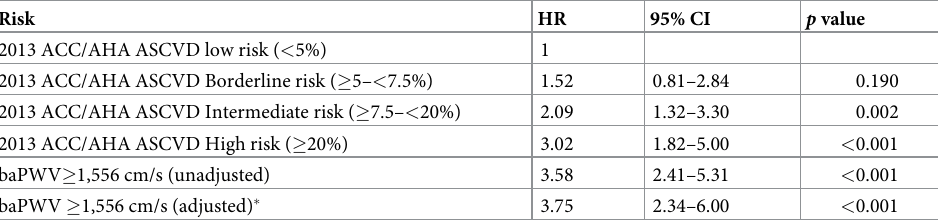
Table 3. Prognostic values of 2013ACC/AHA risk score and baPWV in predicting cardiovascular events. Risk HR 95% CI p value 2013 ACC/AHA ASCVD low risk ( < 5%) 1 2013 ACC/AHA ASCVD Borderline risk ( � 5– < 7.5%) 1.52 0.81–2.84 0.190 2013 ACC/AHA ASCVD Intermediate risk ( � 7.5– < 20%) 2.09 1.32–3.30 0.002 2013 ACC/AHA ASCVD High risk ( � 20%) 3.02 1.82–5.00 < 0.001 baPWV � 1,556 cm/s (unadjusted) 3.58 2.41–5.31 < 0.001 baPWV � 1,556 cm/s (adjusted) � 3.75 2.34–6.00 2013 ACC/AHA ASVD risk score: 2013 American College of Cardiology/American Heart Association atherosclerotic cardiovascular disease risk score, baPWV: brachial-ankle pulse wave velocity, HR: hazard ratio, CI: confidence interval. � Covariates were controlled as potential confounders: Age, Sex, BMI, HR, DM, HTN, Dyslipidemia, Smoking, Beta blockers, RAS blockers,